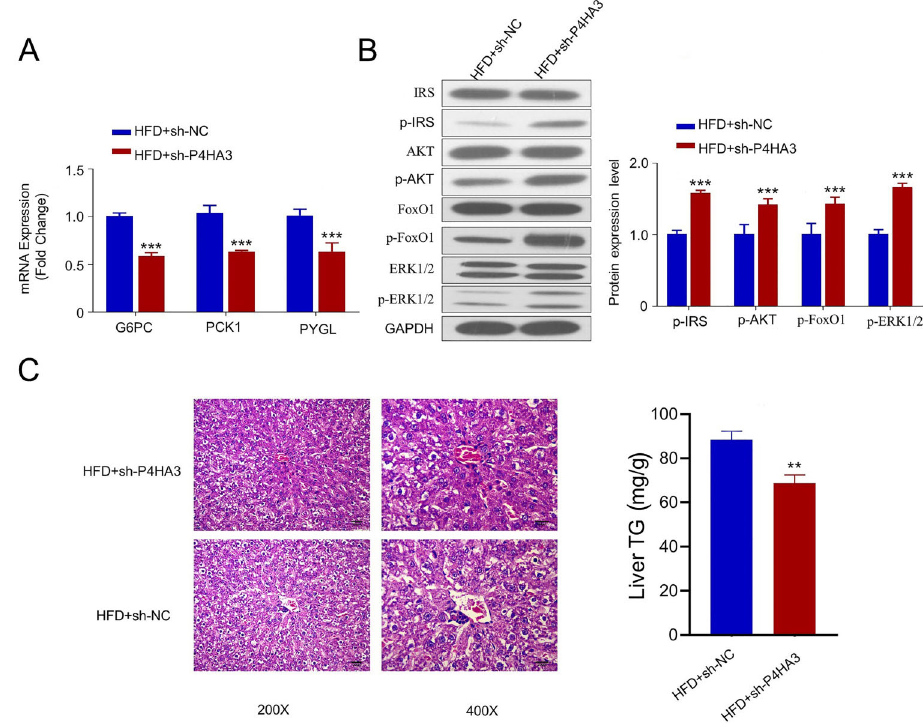
Figure 5. P4HA3 improves hepatic glucose homeostasis and steatosis in db/db mice. A , The expression levels of gluconeogenesis genes ( G6PC and PCK1 ) and glycogenolytic gene ( PYGL ) in liver tissues of db/db mice were determined by RT-qPCR. Mice were sacri fi ced after 6-h fasting for tissue collection. B , The phosphorylation levels of FoxO1, IRS, PI3K, and AKT in liver tissues of db/db mice with or without P4HA3 knockdown were analyzed using western blotting. C , Hepatic steatosis and liver triglycerides (TG) levels in db/db mice with or without P4HA3 knockdown were examined by HE staining (scale bar, 20 m m) and TG kit. HFD: high fat diet; NC: negative control. Data are reported as means ± SD. **P o 0.01, ***P o 0.001 ( t